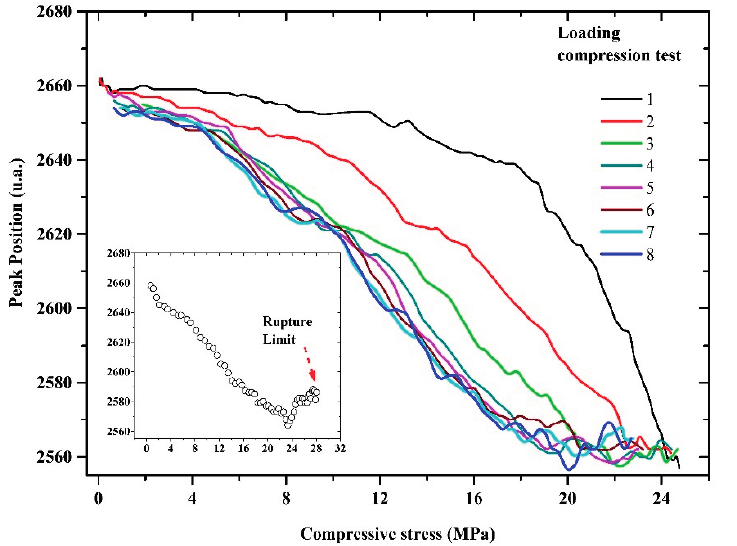
Figure 10. Variation of the peak position of the embedded MMCC sensor.